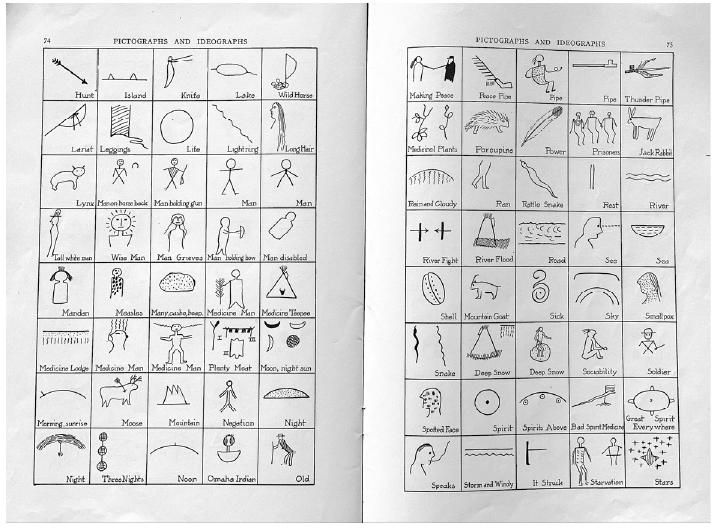
Figure 30. Illustration from Universal Indian Sign Language (Tomkins 1929).